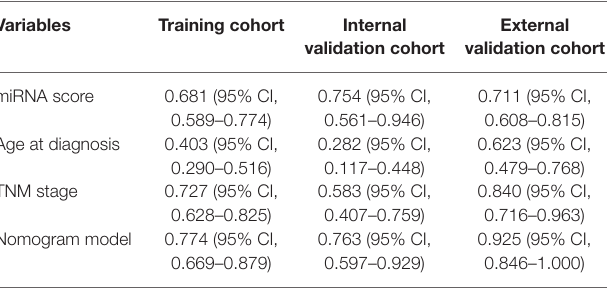
TABLE 3 | Area under the receiver operating characteristics curve (AUC) of prognostic indicators for lung metastasis in breast cancer (BC).